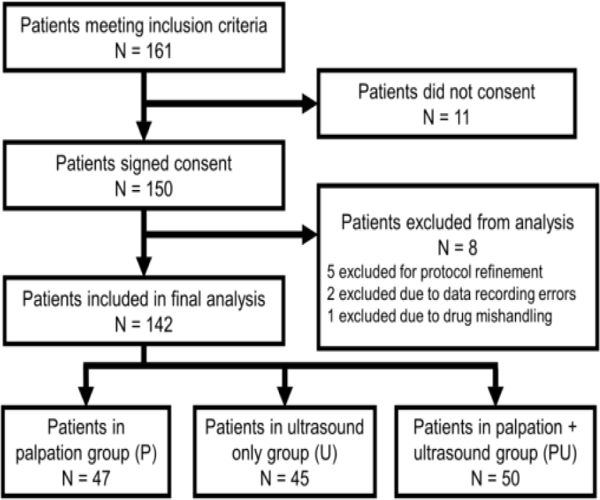
Flow diagram of subject management.